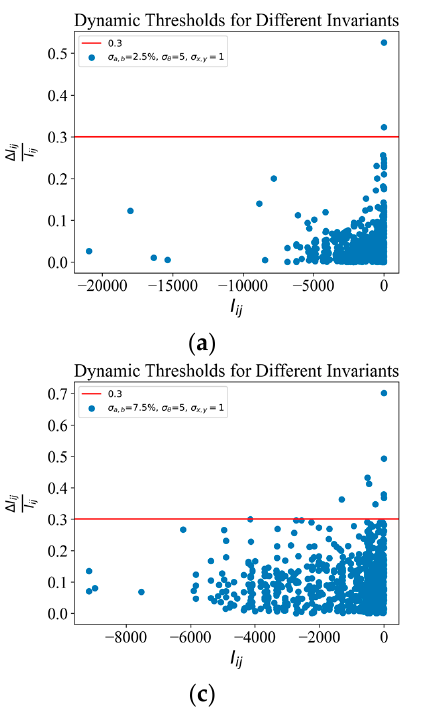
Figure 12. Dynamic thresholds for different invariants with σ a , b increasing: ( a ) σ a , b = 2.5%, ( b ) σ a , b = 5.0%, ( c ) σ a , b = 7.5%, and ( d ) σ a , b = 10.0%.